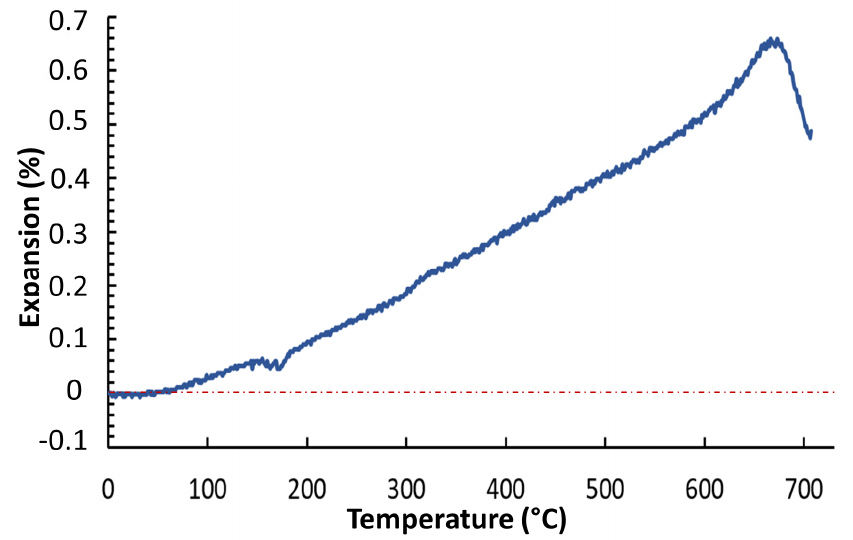
Figure 2. Thermo–dilatometric curve of BGMSN.